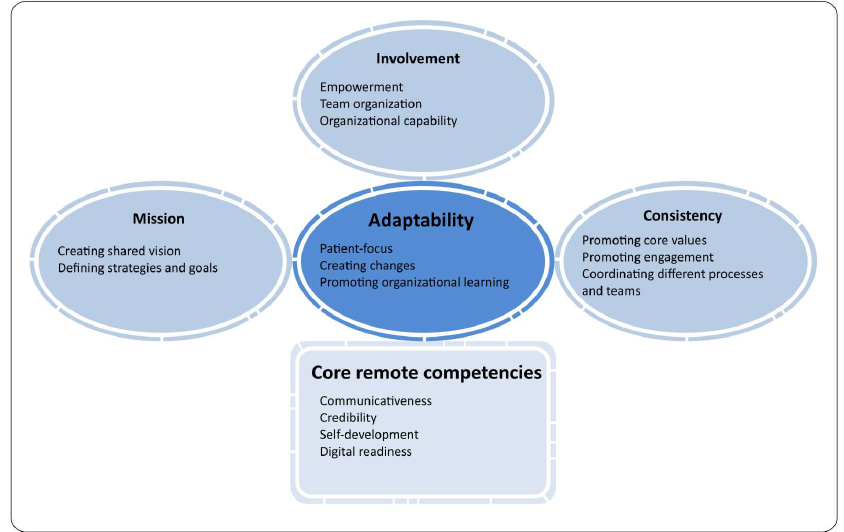
Figure 3. The model of healthcare leadership strategies important to hybrid employees’